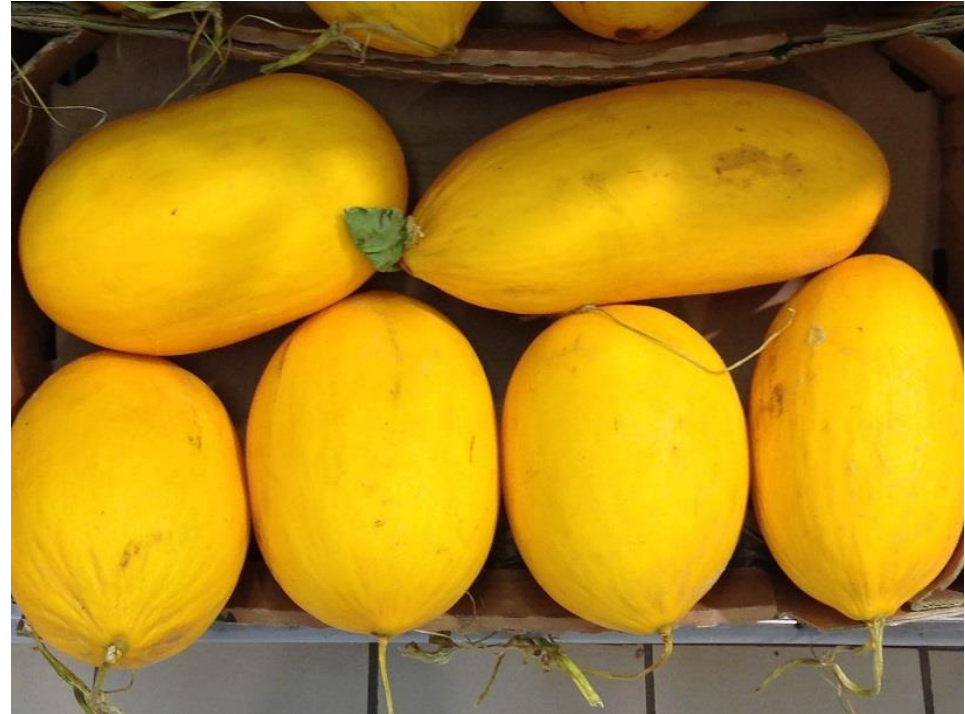
Figure 2. Canary melon landrace in Marrakech, Morocco local market. Notice fruit size and shape inconsistency.